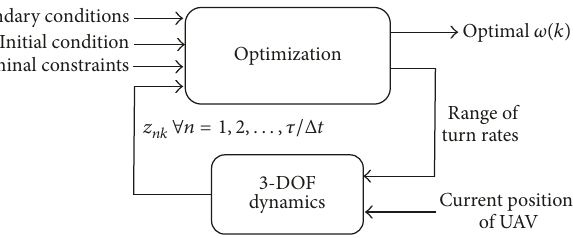
Figure 3: Model-based